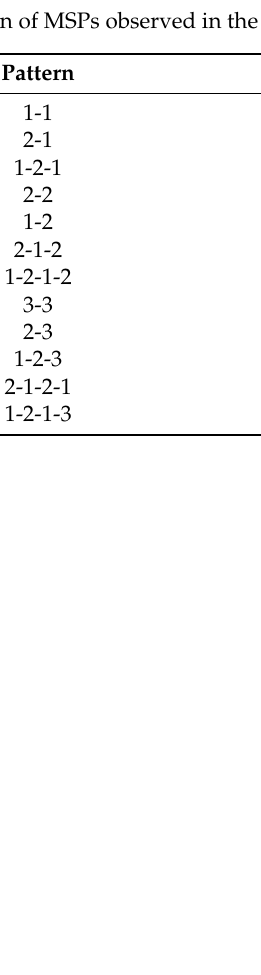
Table 1. Distribution of the canal configuration of MSPs observed in the study.